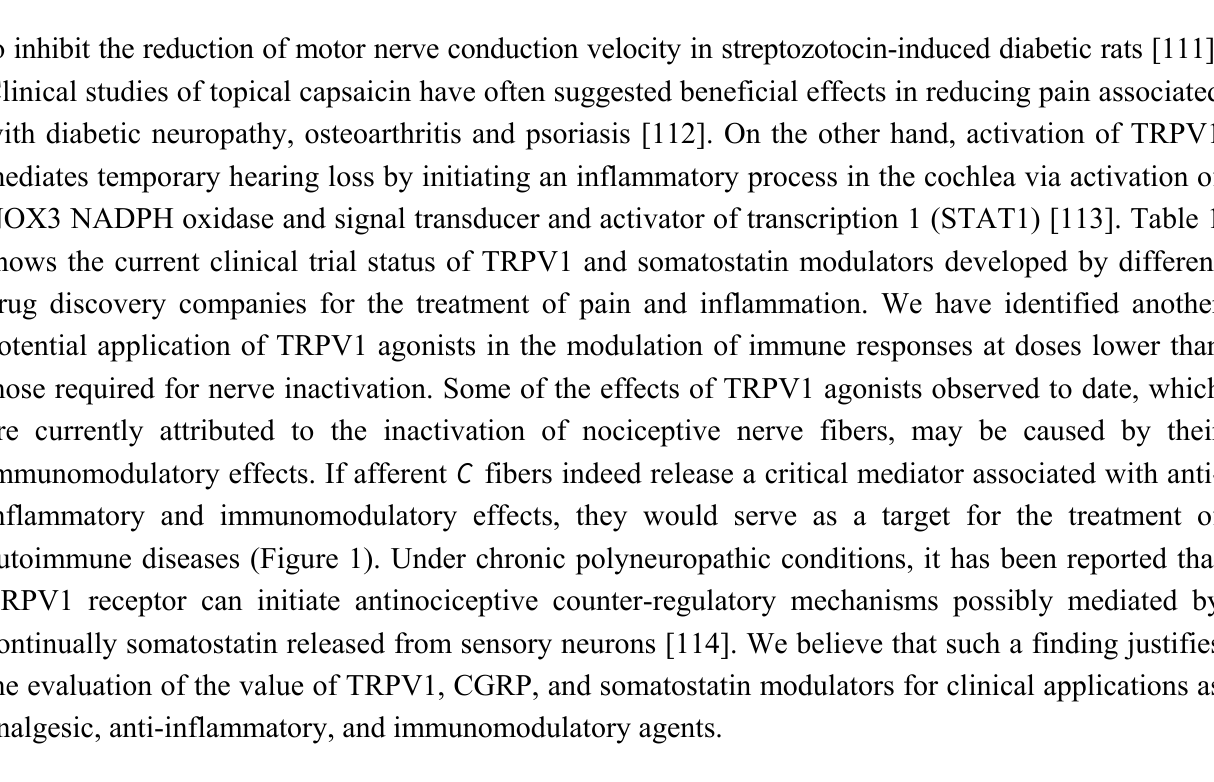
Figure 1. Potential mechanism of the anti-inflammatory and immunomodulatory effects of TRPV1